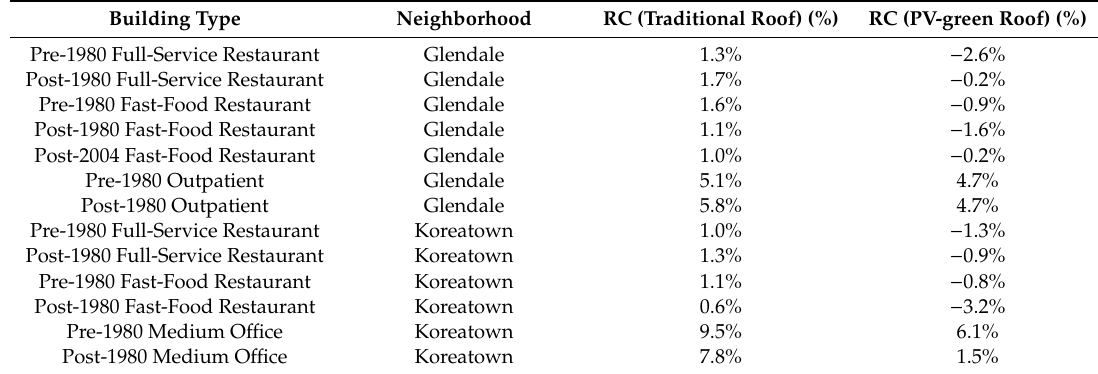
Table 5. Relative change (%) in annual electricity energy demand between 2050 and present (1991–2005) in all tested buildings under the A1F1 emission